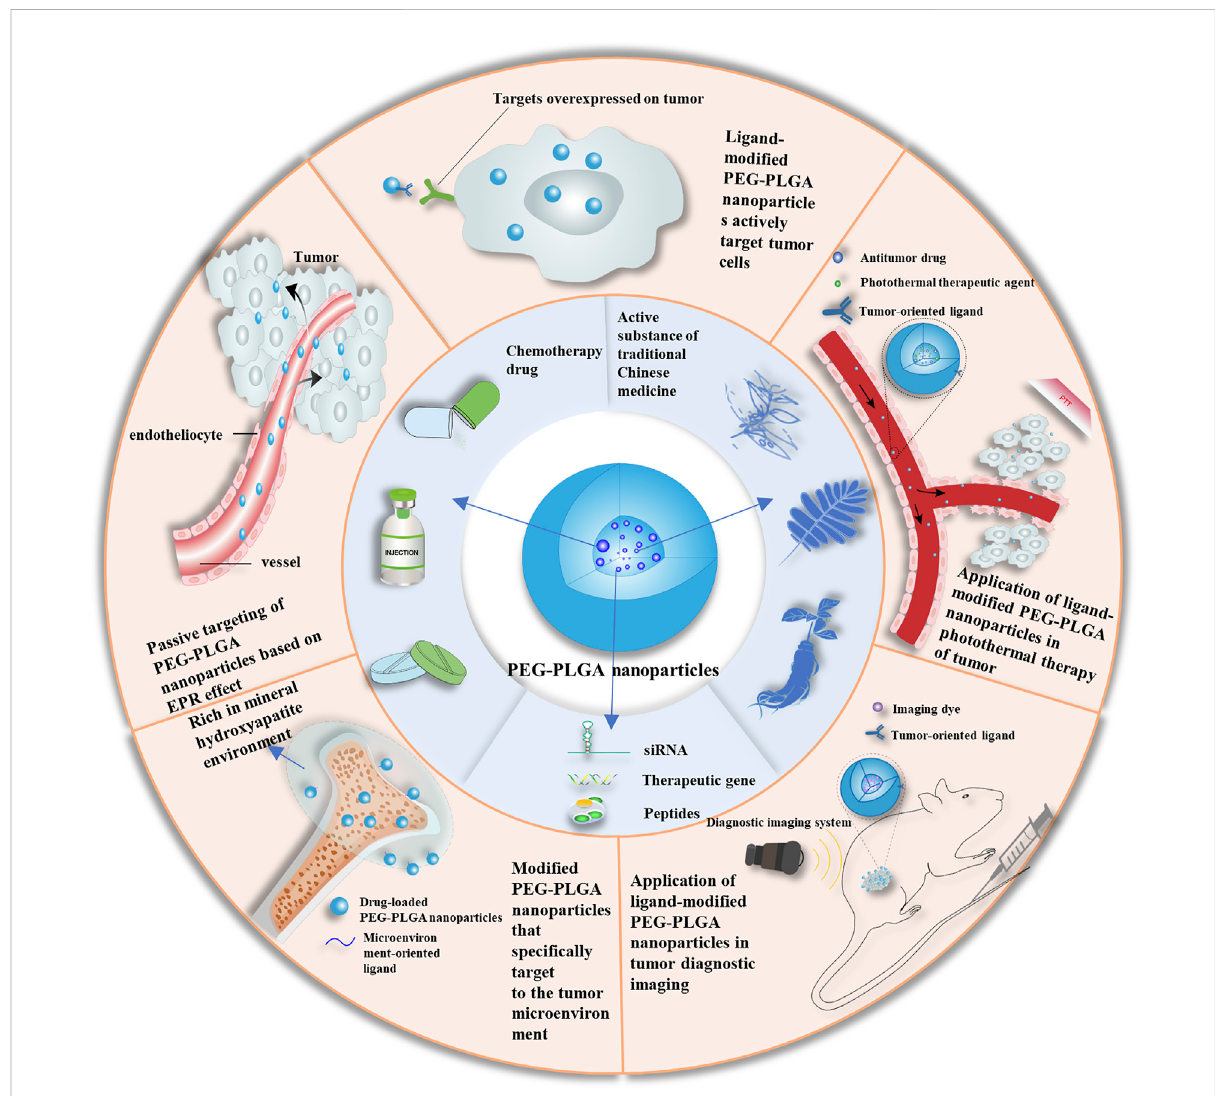
FIGURE 1 Schematic of applications of PEG-PLGA nanoparticles. EPR, enhanced permeability and retention enhanced permeability and retention; PEG, polyethylene glycol; PLGA, poly (lactic acid-co-glycolic acid); siRNA, short interfering